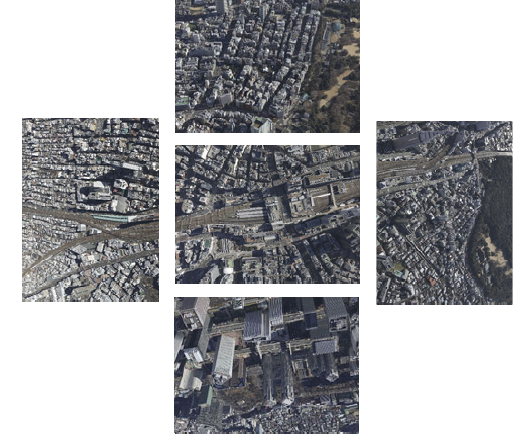
Figure 7. Image captured via oblique